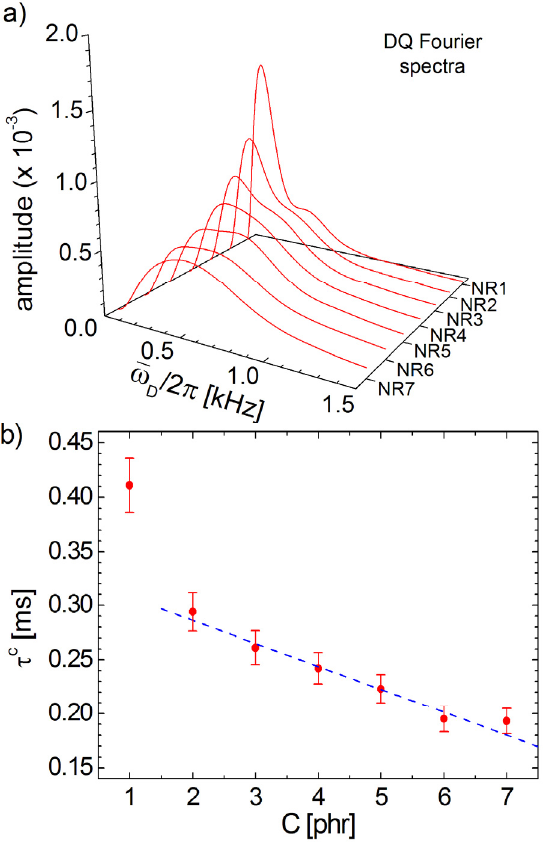
Figure 4. ( a ) Double-quantum Fourier spectra obtained from the DQ build-up curves the series of six-years aged cross-linked NR samples. ( b ) The dependence of the correction effective relaxation time functions of cross-link density. The dashed lines represent the linear fit of data for samples NR2 up to